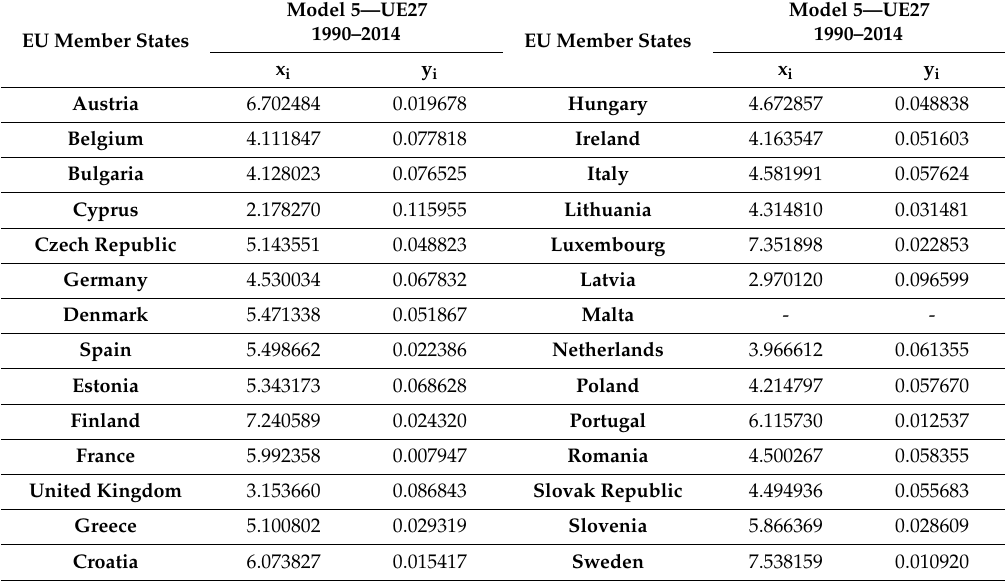
Table 4. β -convergence of renewable energy consumption for Model 5 of the